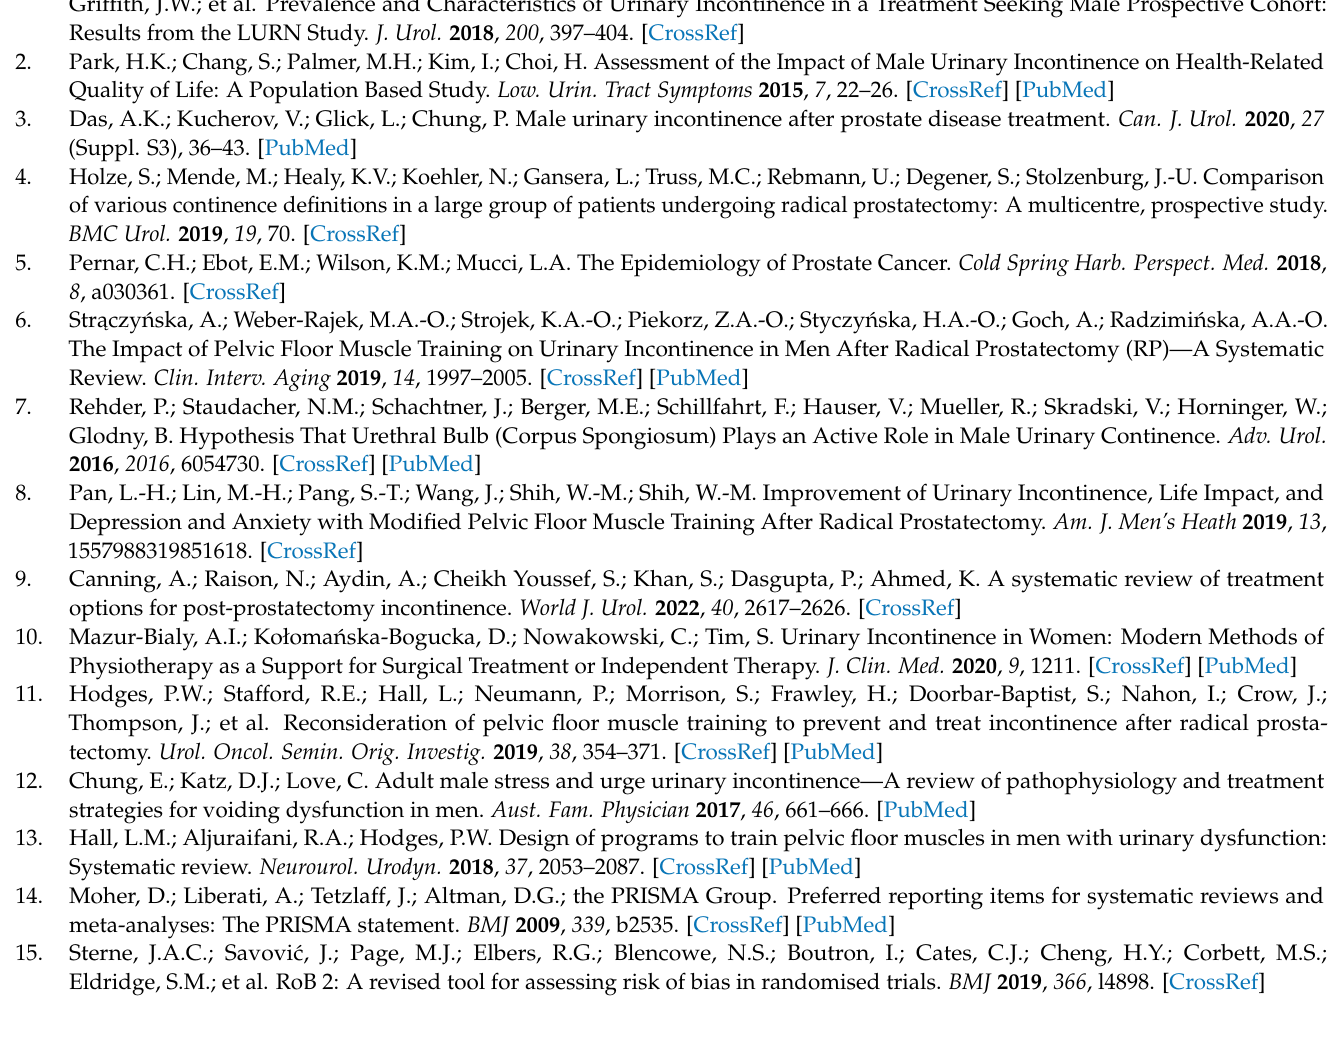
Figure A2. Summary plot of the overall risk of bias ( n = 55).